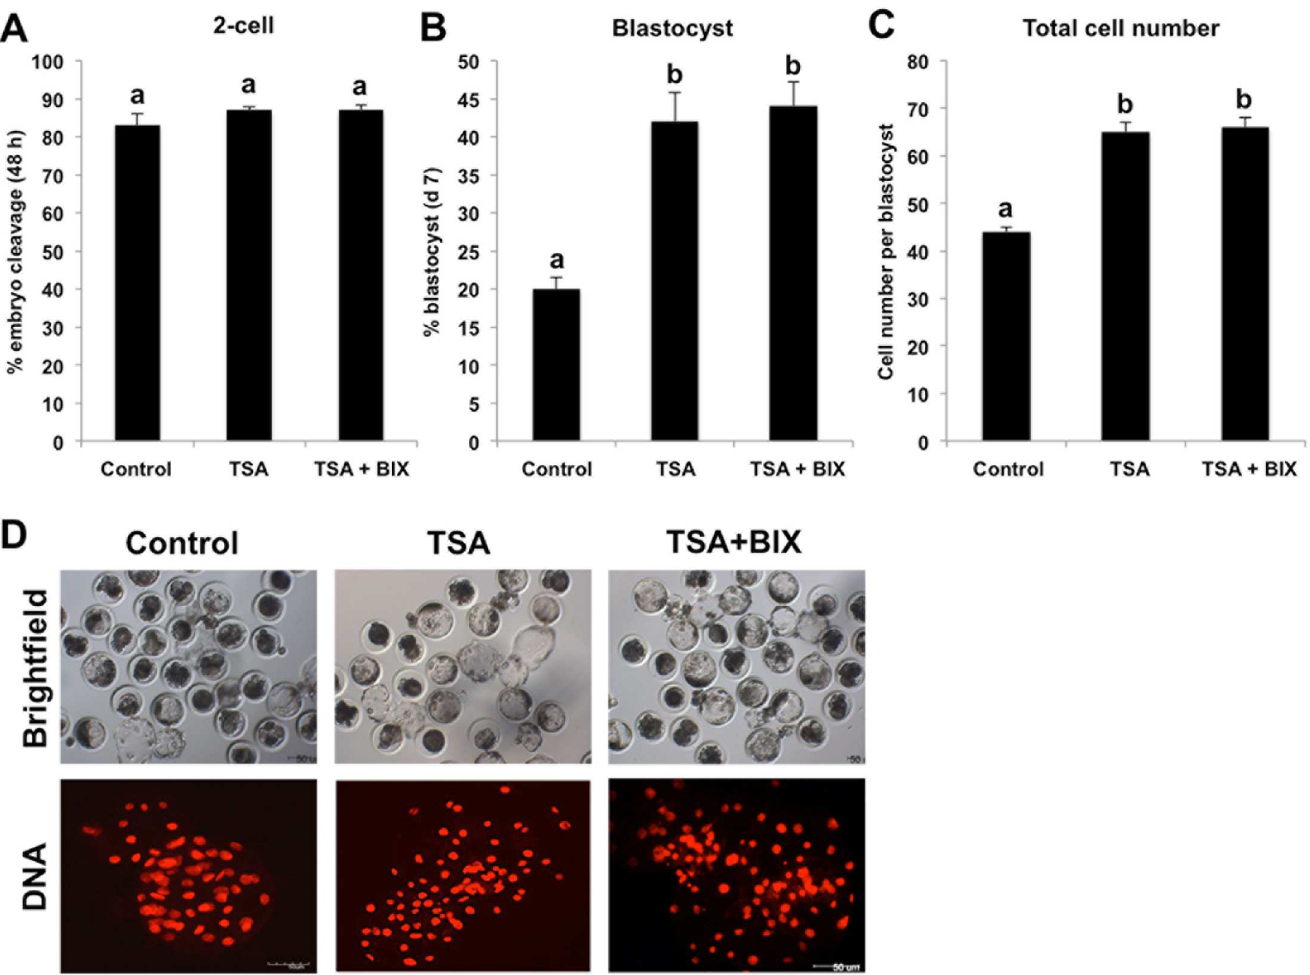
Fig 3. TSA and BIX-01294treatment combined enhances early developmental efficiency of SCNT embryos. SCNT embryos at the pronuclear stage were cultured in PZM-3 supplemented with 50 nM TSA or 50 nM TSA and 1 μ M BIX-01294for 24 h and embryos culturedin PZM-3 containing DMSO were served as NT control, then DMSO, TSA and BIX-01294in different groups were washedout and embryos were cultured in fresh PZM-3 medium until day7. The effect of HDACs and G9A inhibition on the proportionof embryos that reachedthe 2-cell stage within 48 h after activation (A) , proportionof embryos developingto the blastocyst stage (Day 7) (B) and total cell number per blastocyst (C) are shown. The experiment was repeated at least three times with 220 embryos per group. All the percentage data are expressedrelative to the number of 1-cell embryos and are shown as mean ± S.E.M. Valueswith different superscripts across treatments indicatesignificantdifferences( P < 0.05). (D) Representative images of SCNT blastocysts from different groups under bright field. DNA was labeledwith propidiumiodide(red). Scale bars = 50 μ m.